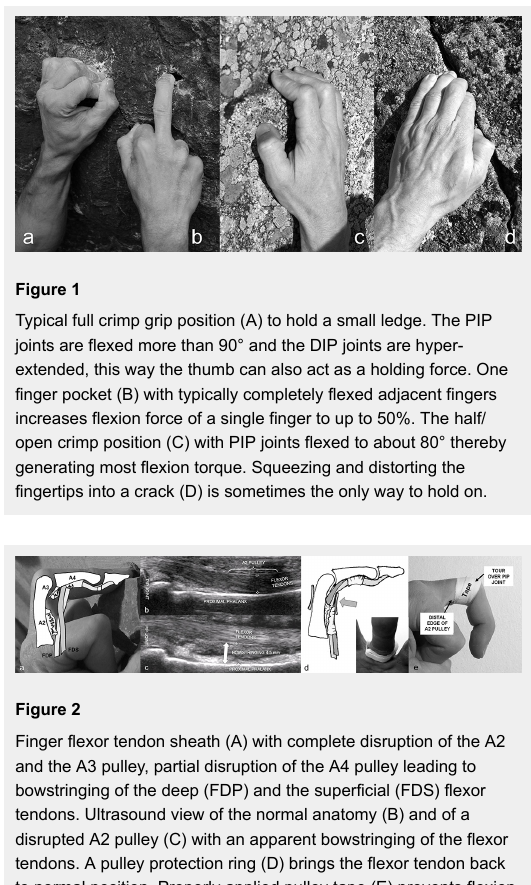
Finger flexor tendon sheath (A) with complete disruption of the A2 and the A3 pulley, partial disruption of the A4 pulley leading to bowstringing of the deep (FDP) and the superficial (FDS) flexor tendons. Ultrasound view of the normal anatomy (B) and of a disrupted A2 pulley (C) with an apparent bowstringing of the flexor tendons. A pulley protection ring (D) brings the flexor tendon back to normal position. Properly applied pulley tape (E) prevents flexion of the PIP joint of more than